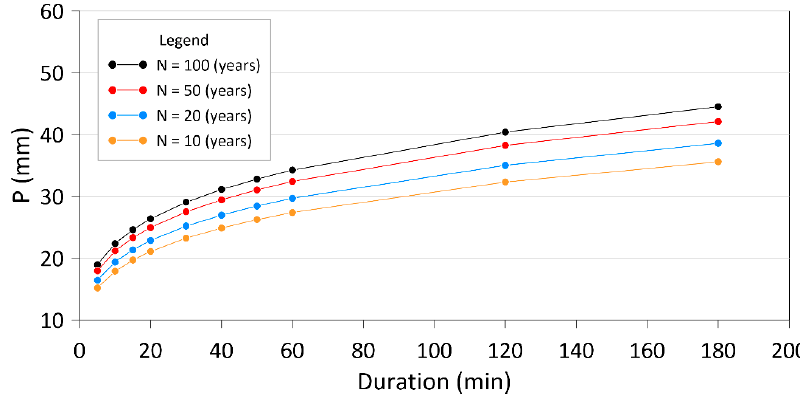
Figure 11. The actual design values of the short-term rainfall for the Vyšná Boca climatological station.